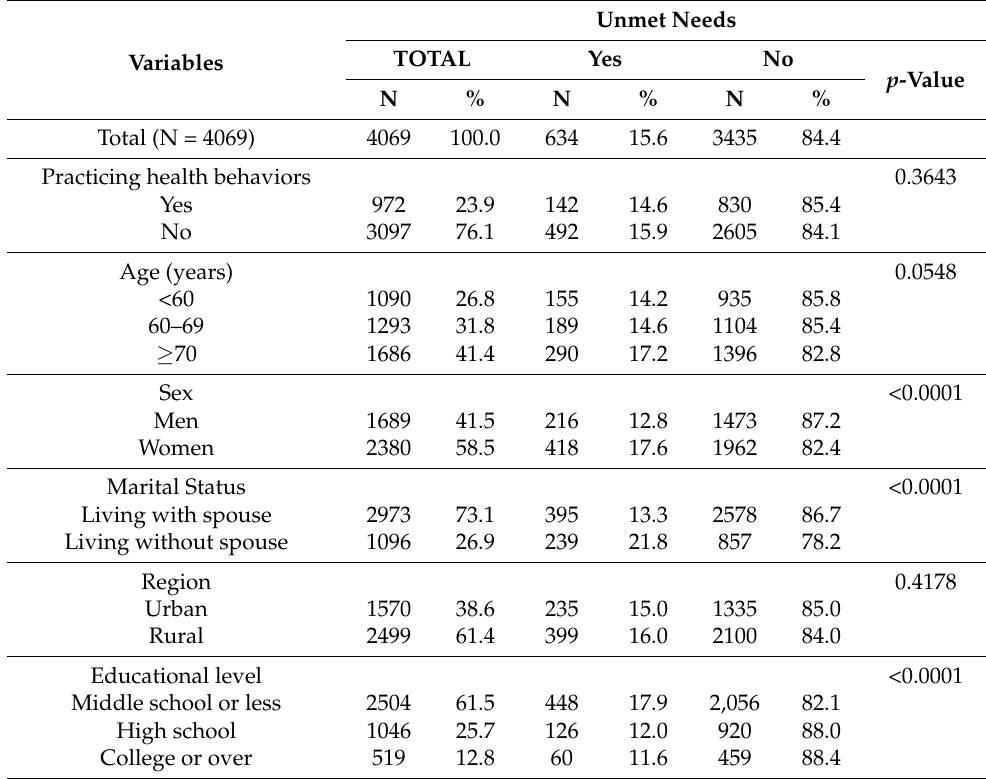
Table 1. General characteristics of the study population categorized by unmet needs at the 2014